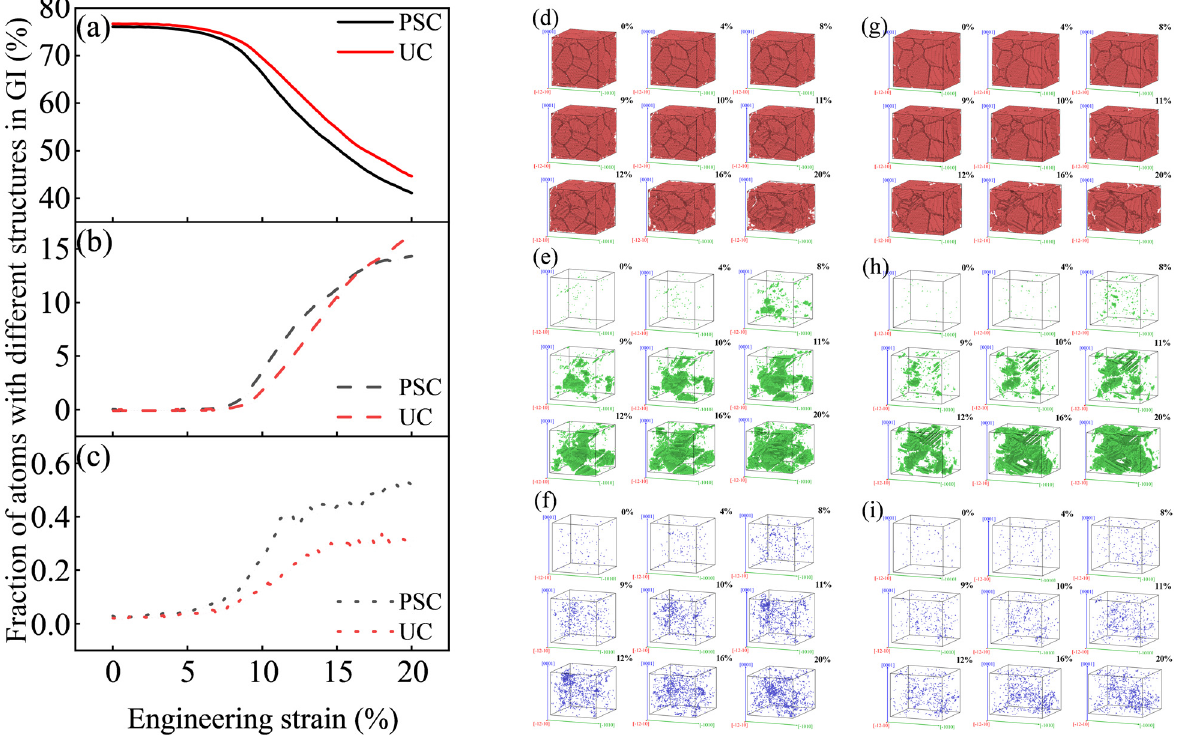
Figure 7: Structural evolution: ( a ) HCP structure fraction curve, ( b ) FCC structure fraction curve, ( c ) BCC structure fraction curve, ( d ) – ( f ) structural evolution diagram under PSC, and ( g ) – ( i ) structural evolution diagram under